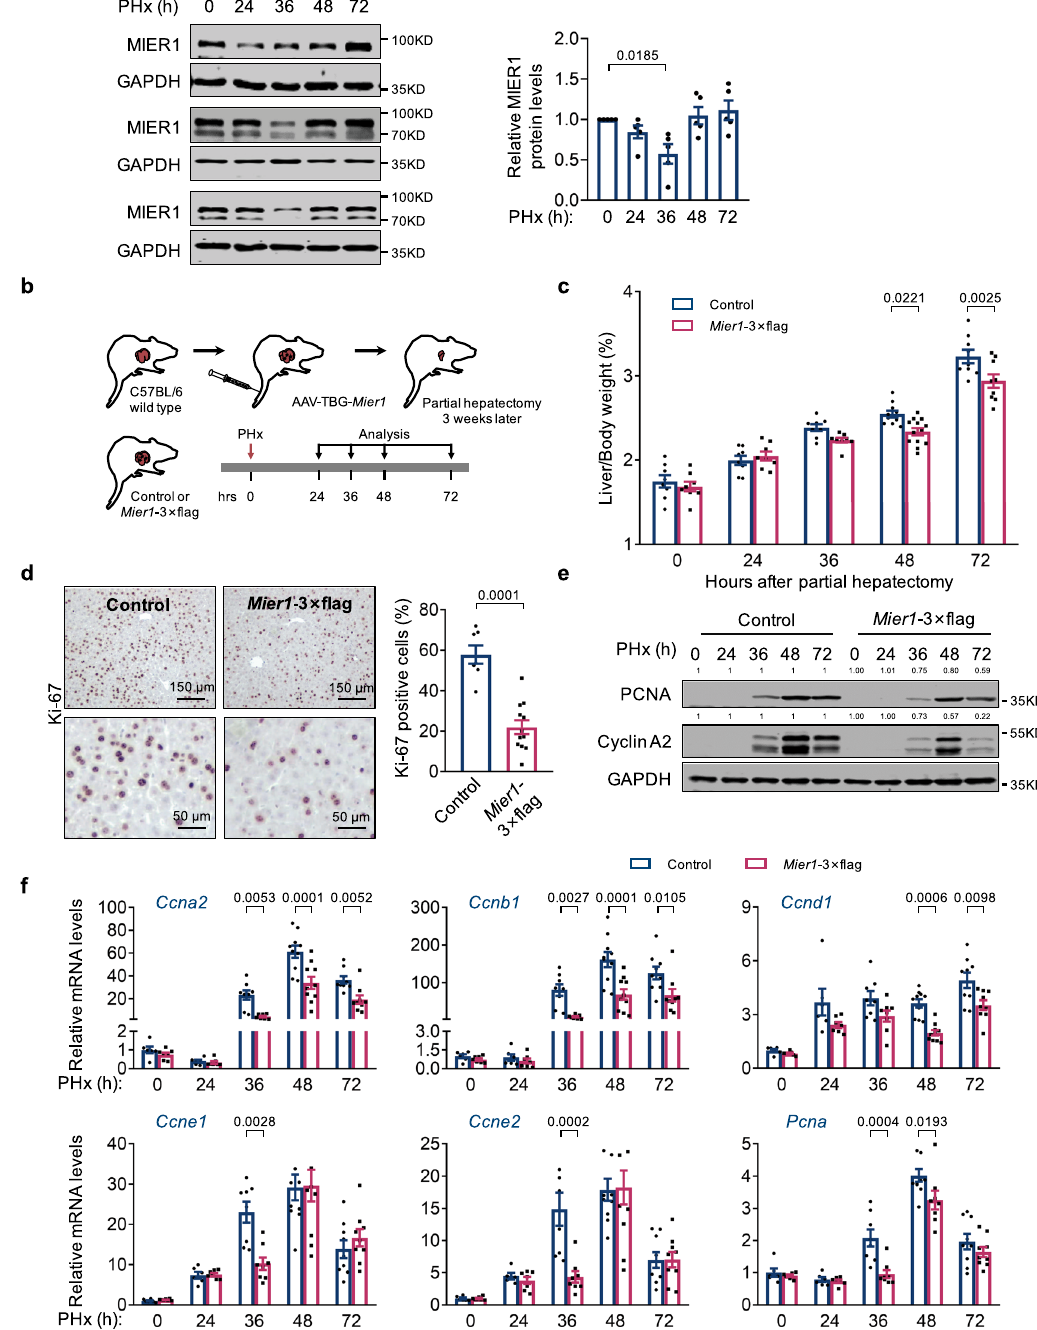
Fig. 3 | MIER1 overexpression delays liver regeneration. a Immunoblots (MIER1 and GAPDH) in liver tissues before or after hepatectomy. n =5. b Schematic pre- sentation of study with MIER1 overexpression. The liver/body weight ratio (%) ( c ) ( n =8, 8, 8, 10, 9 in Control group, and n =8, 8, 8, 13, 9 in Mier1- 3× fl ag group, in different time points after PHx), liver Ki-67 immunostaining ( d ) ( n =7 in Control group, and n =12 in Mier1- 3× fl ag group), liver immunoblots (Cyclin A2, PCNA, and GAPDH)( e ),andmRNAlevelsoflivercellcyclegenes( f )( n =6,6,8,10,9inControl group,and n =7,7,8,10,9in Mier1- 3× fl